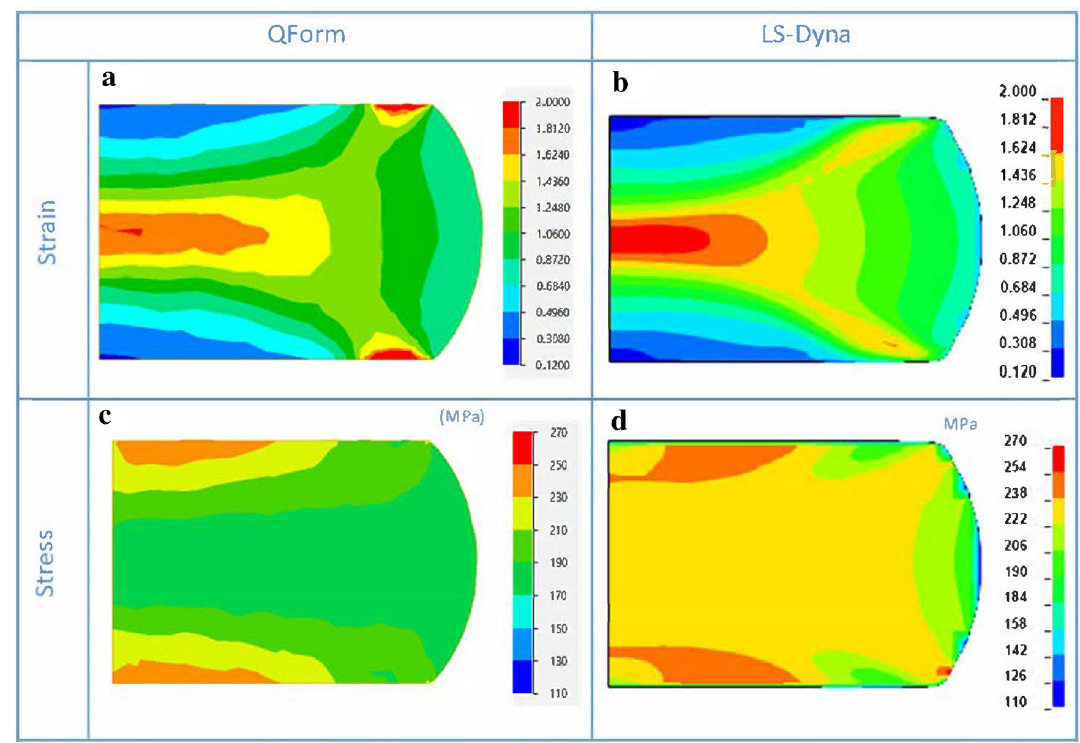
Fig. 6 Calculated strain and stress (effective) at the end of the compression at 900 °C and 30